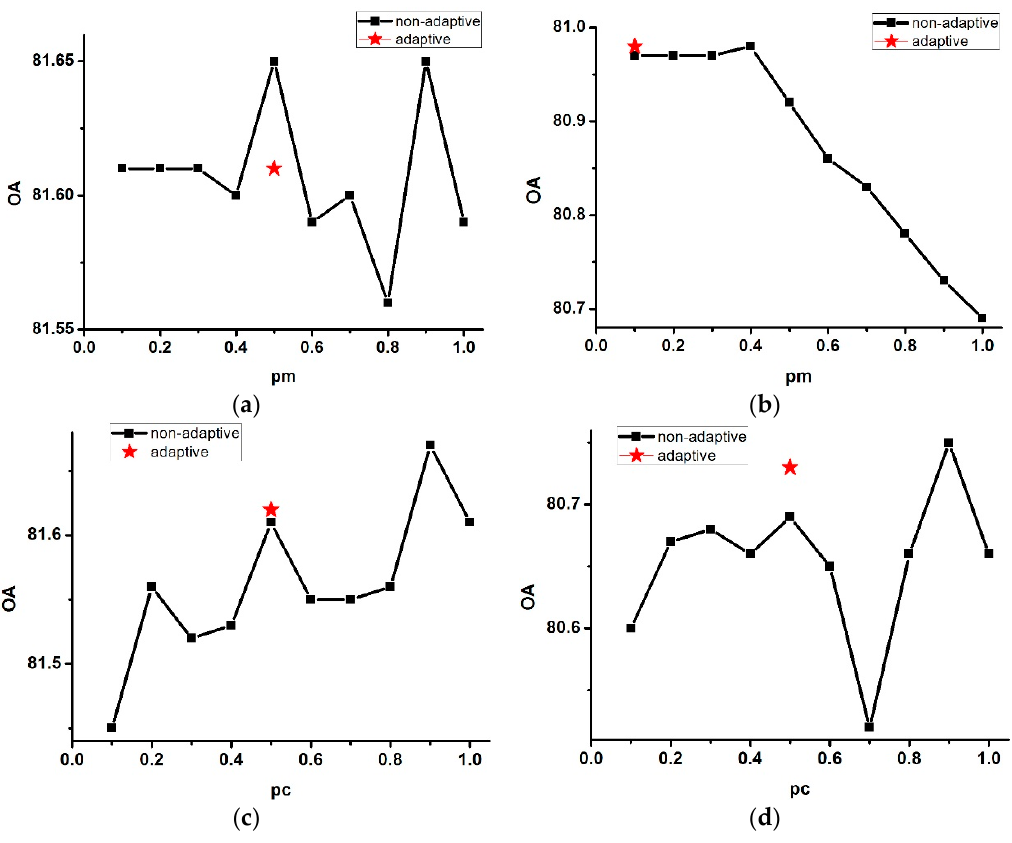
Figure 16. Sensitivity analysis of SSMCS and SSMDE in relation to parameters pm and pc, respectively: ( a ) SSMCS in relation to parameter pm for the Landsat 8 image; ( b ) SSMCS in relation to parameter pm for the QuickBird image; ( c ) SSMDE in relation to parameter pc for the Landsat 8 image; and ( d ) SSMDE in relation to parameter pc for the QuickBird image.